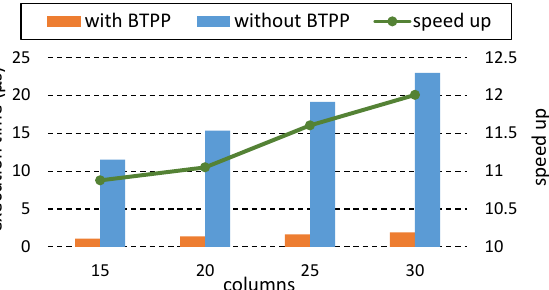
Figure 14. The comparison of execution time between the design using BTPP and the design not using BTPP. The number of rows of the matrix is 15 and the number of columns varies from 15 to